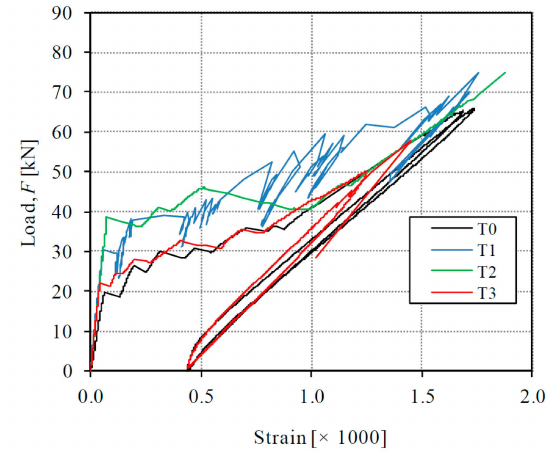
Figure 6. Load-strain curves of tested specimens.